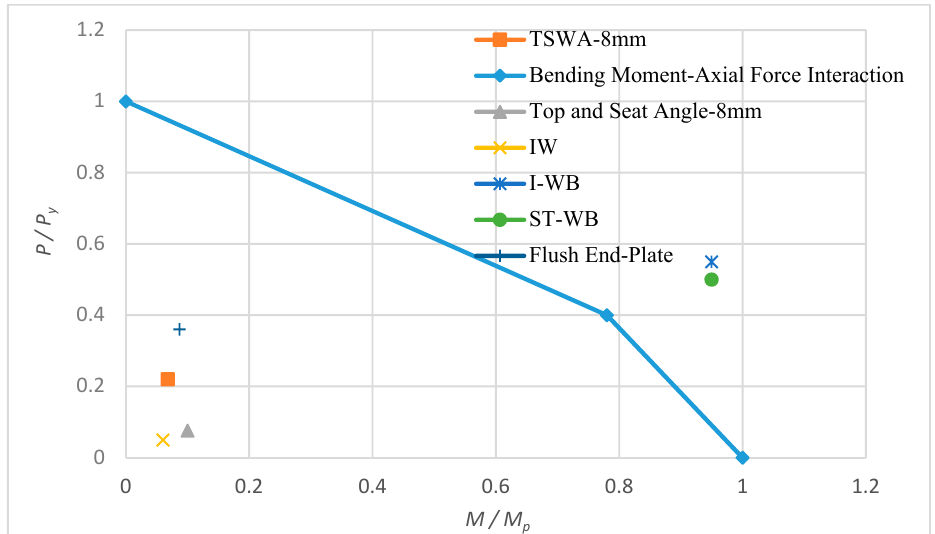
Figure 11. Correlation between axial force and bending moment in studied specimens at the final stage of the pushdown test. Table 4. Modeling Parameters and Acceptance Criteria for Nonlinear Modeling of Steel Frame